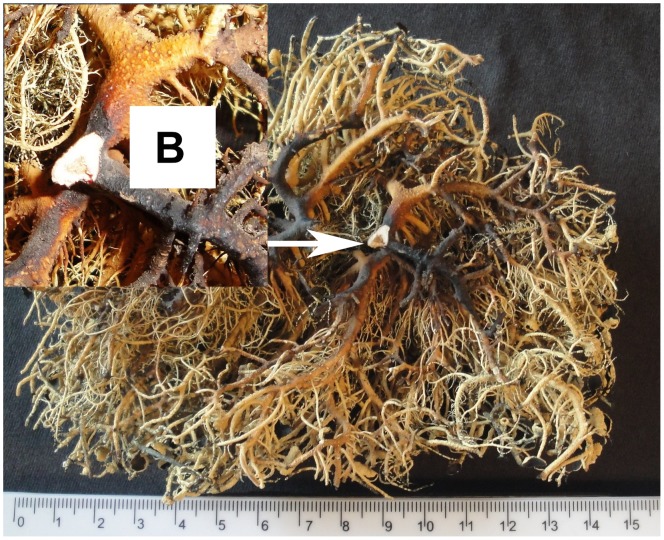
The bottom part of U. aurantiacoatra, the part which was taken as Sample B.